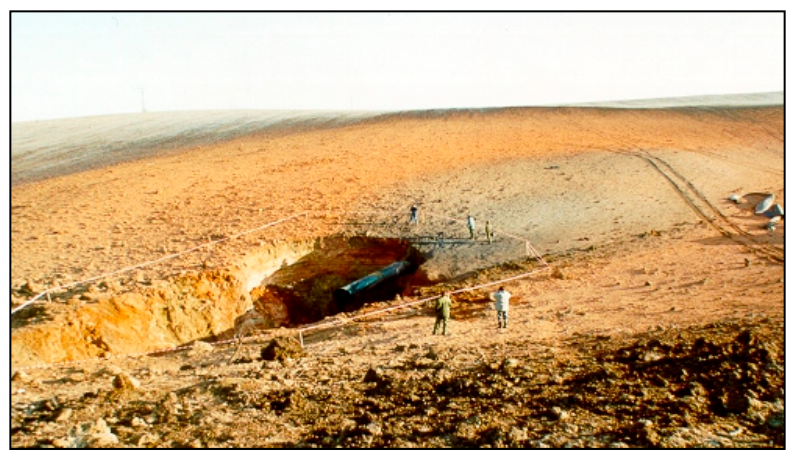
Figure 8. Gas pipeline accident due to the additional bending of a pipeline system laid on a slope with insufficient amounts of compacted subsoil.